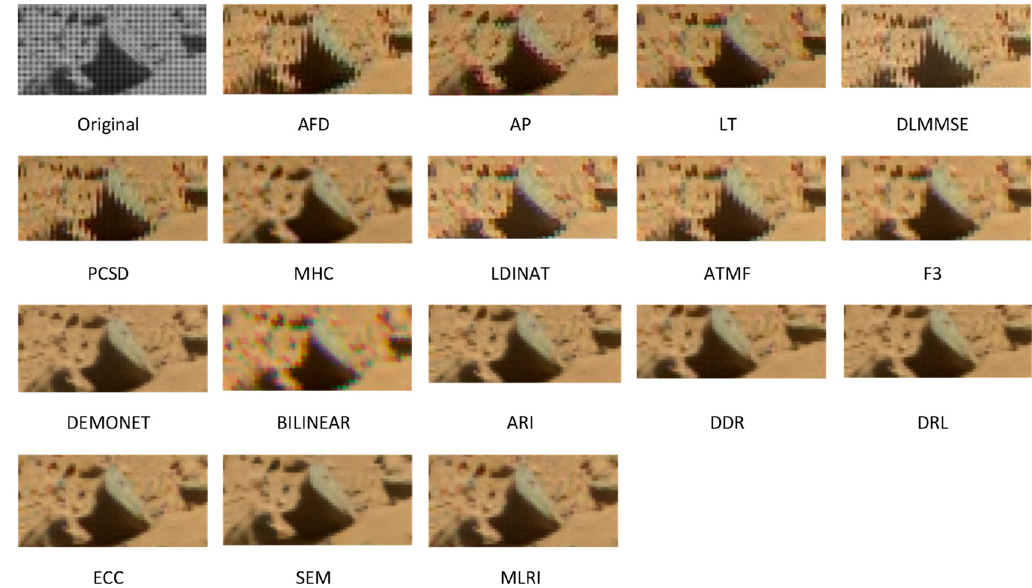
Figure 6. Subjective comparison of demosaiced images of different algorithms for left Mastcam image 1.